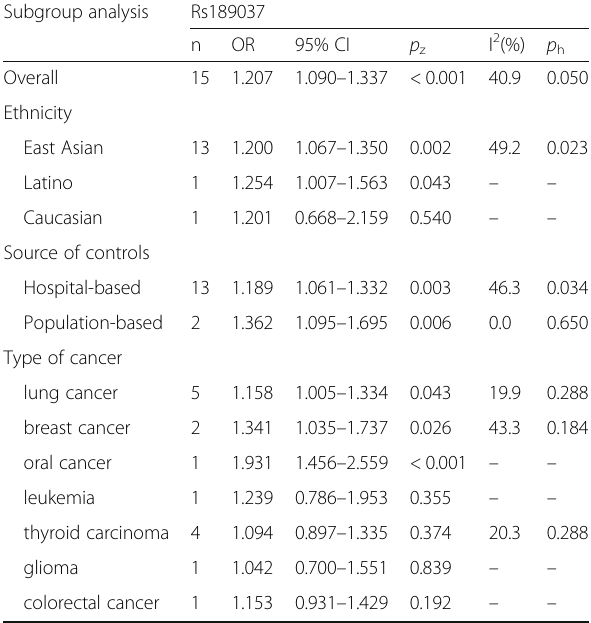
Table 4 Stratified analysis of the association of ATM polymorphisms with cancer under dominant model Subgroup